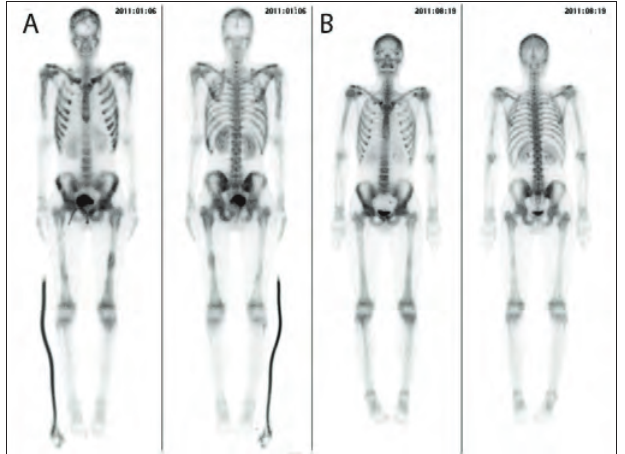
Fig. 4. 99m TcMDP whole-body bone scintigraphy study. (a) Pre-chemotherapy noting multiple osteoblastic metastases in the skull, ribs, both scapulae, the inferior left pubic rami, both femurs and the proximal right humerus. (b) Post- chemotherapy study shows no visible metastases, representing a response to